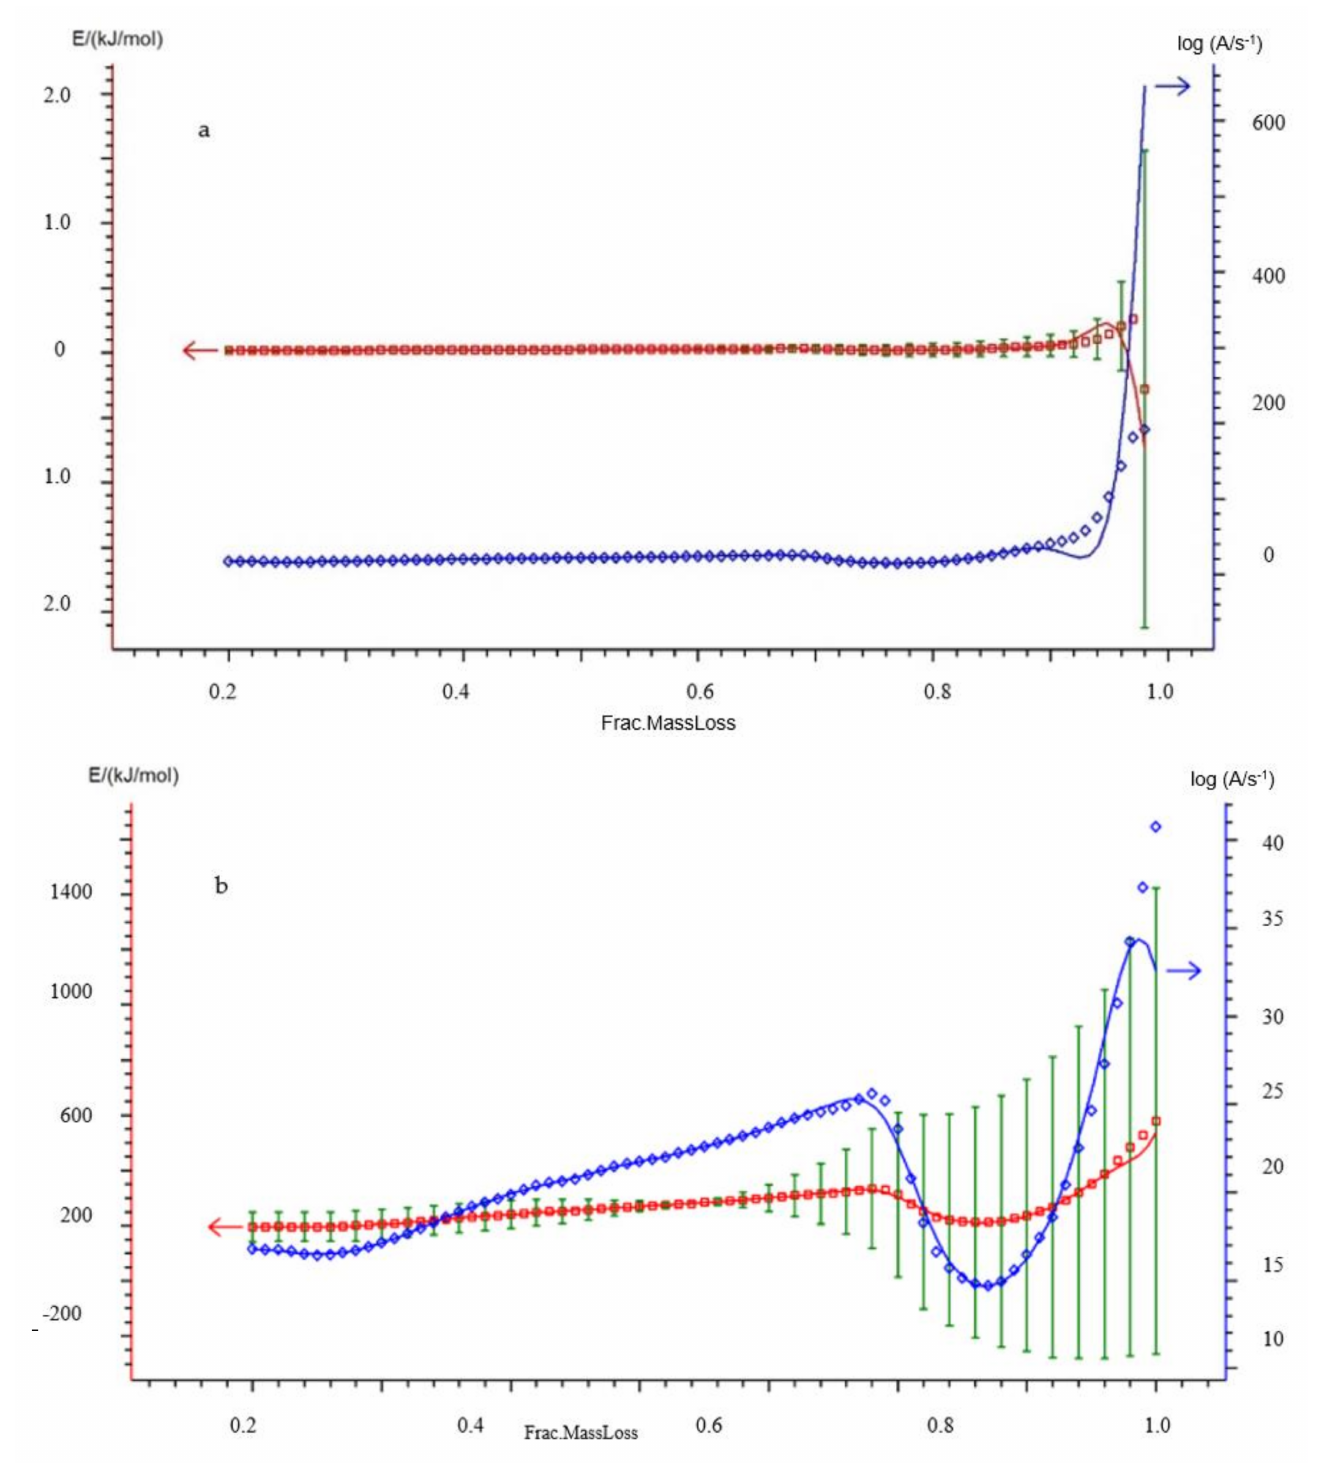
Figure 14. Activation energy (Red color) and pre-exponential coefficient (Blue color) as a function of the conversion degree: ( a ) X = 0.20–0.98, ( b ) X = 0.20–0.90 determined by the Ozawa–Flynn–Wall method for sewage sludge. Green color represents the statistical